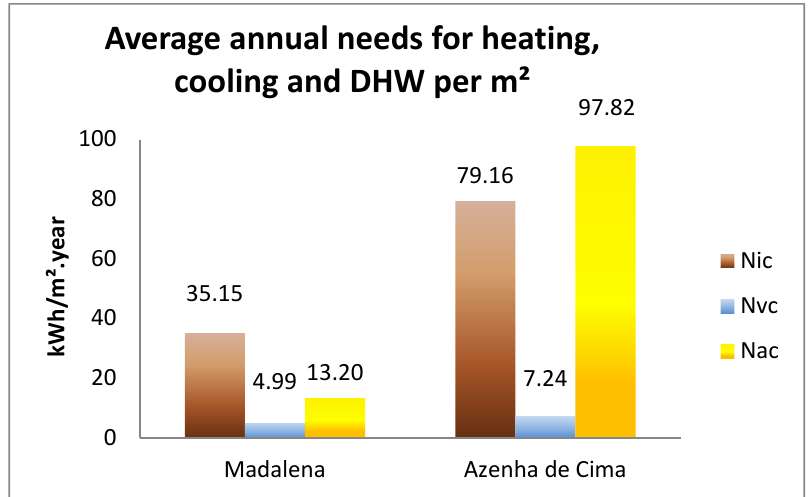
1. Average annual needs for heating (Nic), cooling (Nvc) and DHW (Nac)—Madalena vs . Azenha de